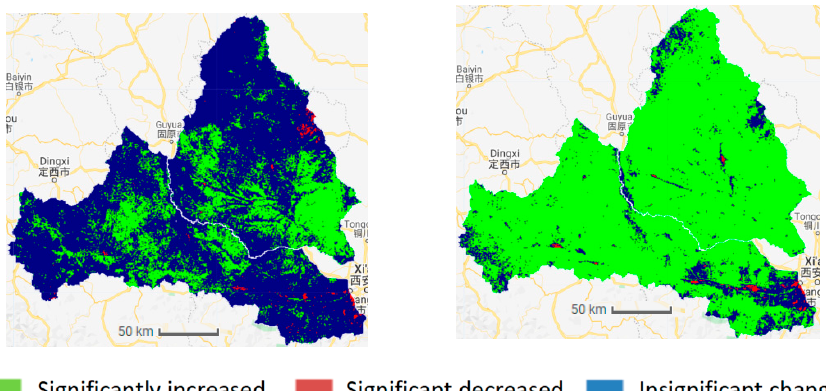
Figure 6. The significant change in NDVI in the Wei and Jing River Basin ( Left : 1987–2008, Right : 1987–2020).